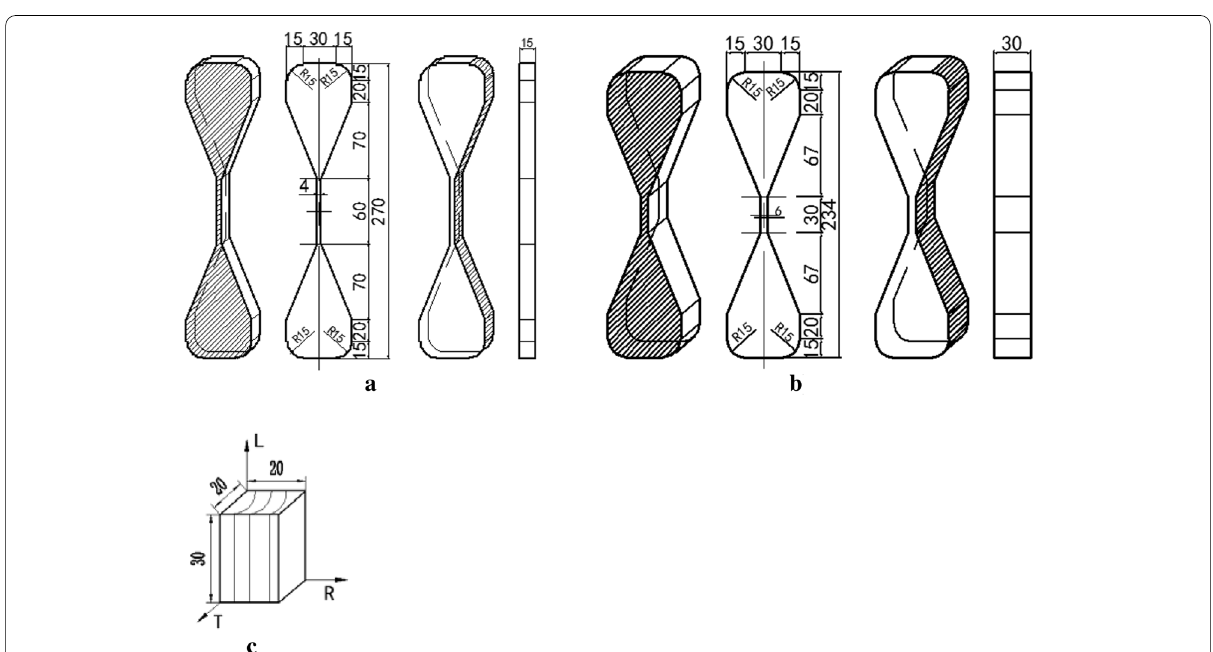
Fig.2 Details of tensile and compression testing sample: a tensile with rift grain, b tensile with radial, and c compression with rift grain (unit: mm)